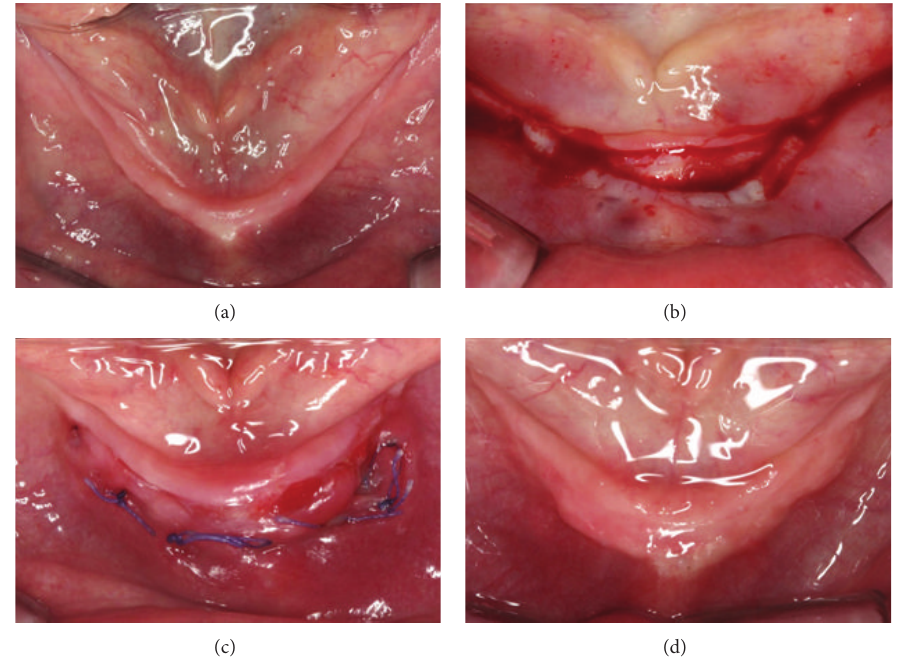
Figure 1: (a) Initial clinical appearance of the mandibular ridge with 3-4 mm of keratinized tissue. (b) Crestal horizontal beveled incision made. (c) The flap sutured apically with Vicryl 4.0 to the periosteum. (d) Final result 3 months after the surgery showed 5 mm increase in the width of keratinized tissue.